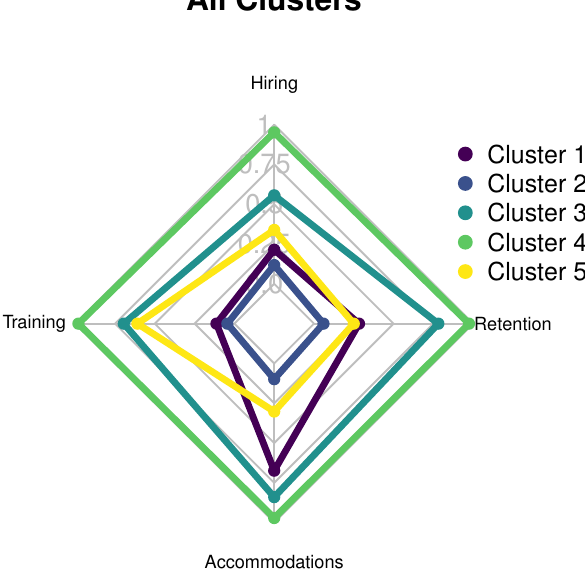
Figure 7. Radar graph for all